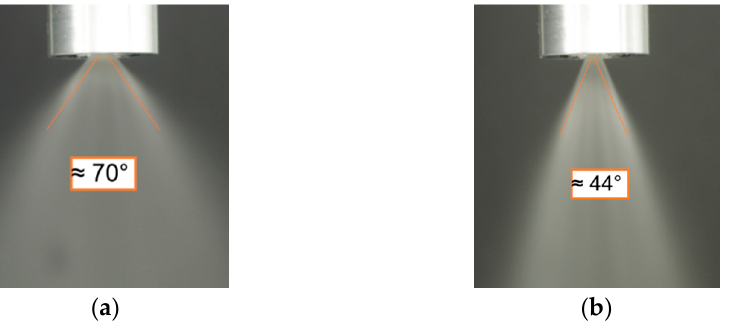
Figure 4. Spray cone angle β for ( a ) liquid fuel operation on primary 1 only at gas turbine ignition flow conditions and ( b ) liquid fuel operation on primary 1 and 2 at high pilot fuel flow rate in quiescent air.